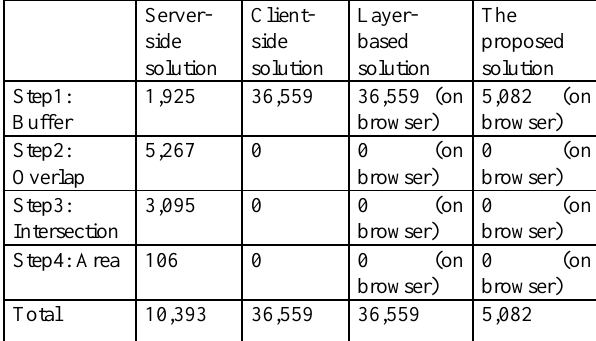
Table 1. Comparisons of the first case study (data amount is measured by